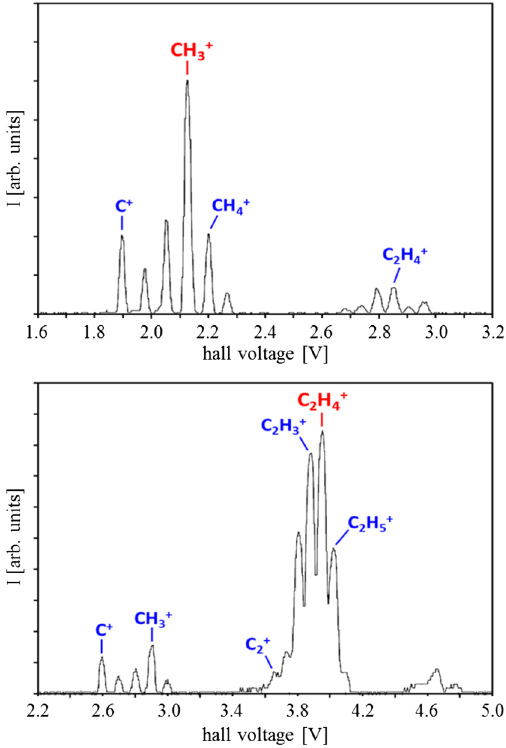
FIG. 5. Mass spectra from methane (upper) and ethane (lower) gas operation. The ion source settings were optimized for the production of CH 3 þ and C 2 H 4 þ respectively; the specific energy is fixed for 2 . 2 keV = u